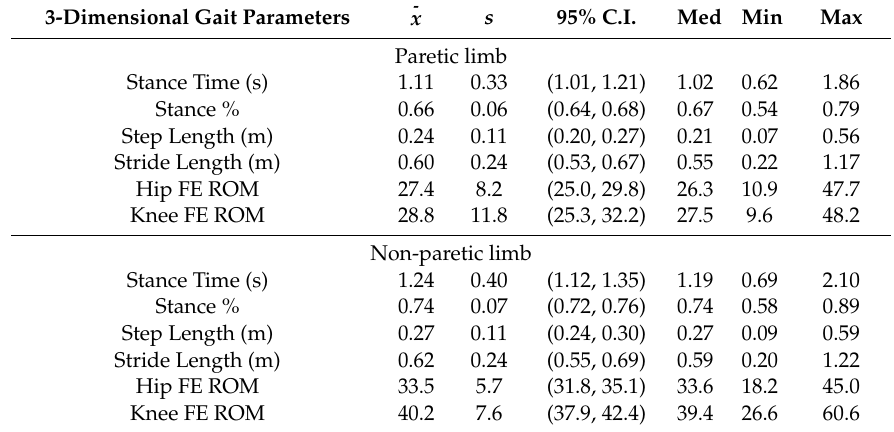
Table 1. Characteristics of spatiotemporal and kinematic gait parameters in the study